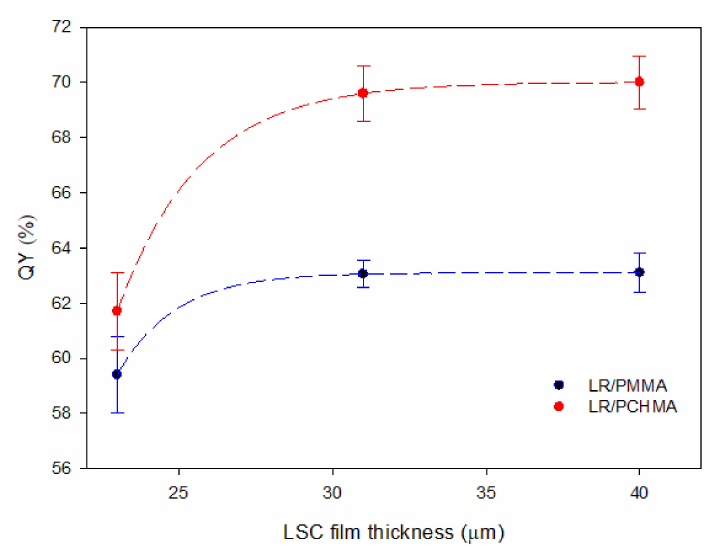
Figure 9. Quantum yield (%) of LR / polymer thin films as a function of LSC film thickness at 1.00 wt% of LR for both polymeric matrices studied. Error bars represent standard deviation in each QY value ( n =